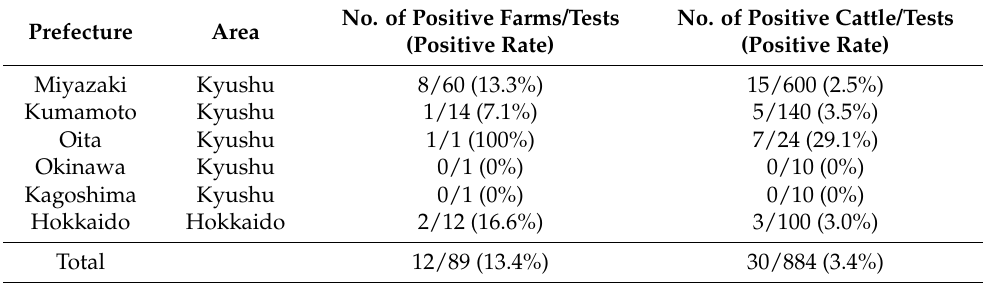
Table 1. Prevalence of bovine foamy virus on 89 farms in the Hokkaido and Kyushu areas in Japan.